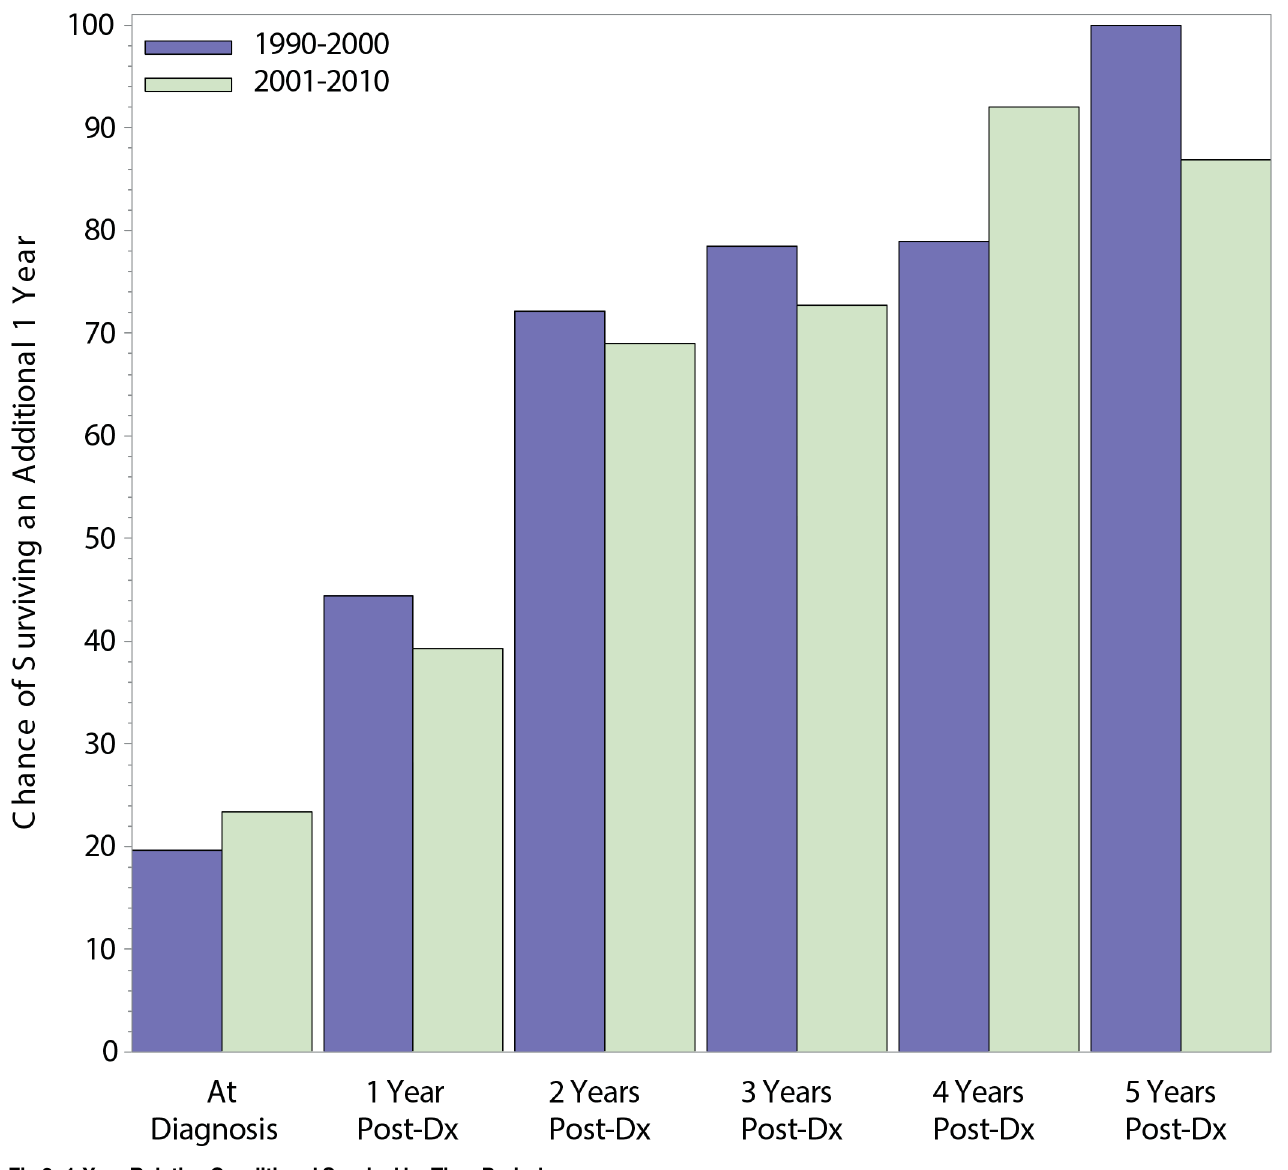
Fig 2. 1-Year Relative Conditional Survival by Time